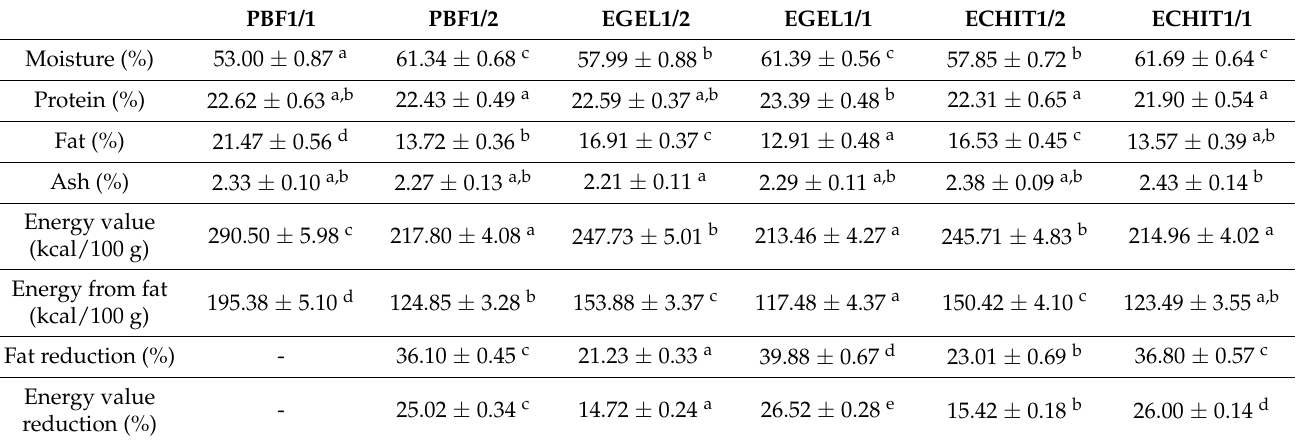
Table 3. Proximate composition and energy values of control and reformulated pork patties